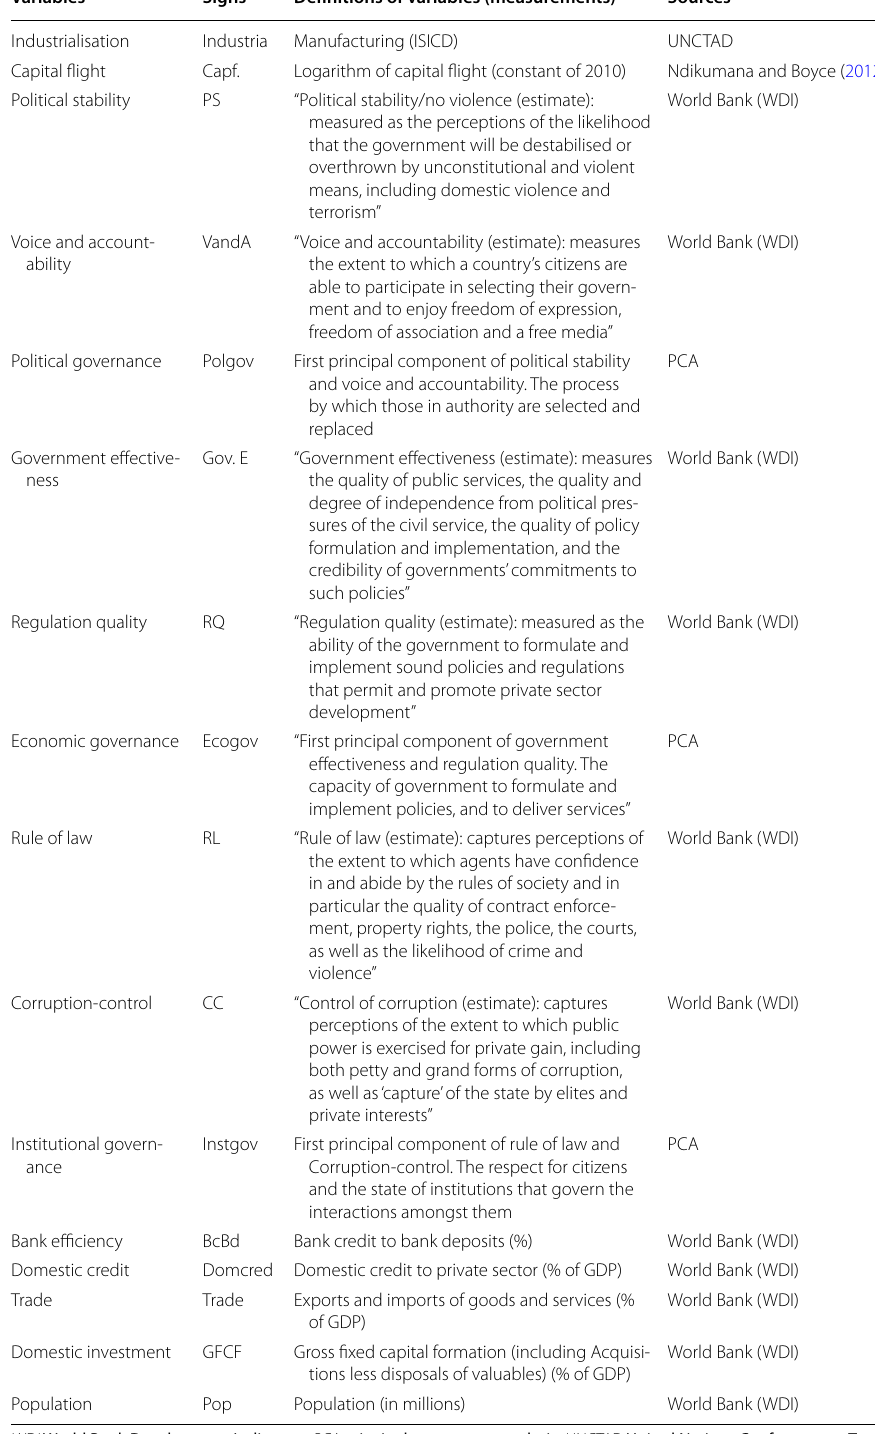
Table 5 Definitions of